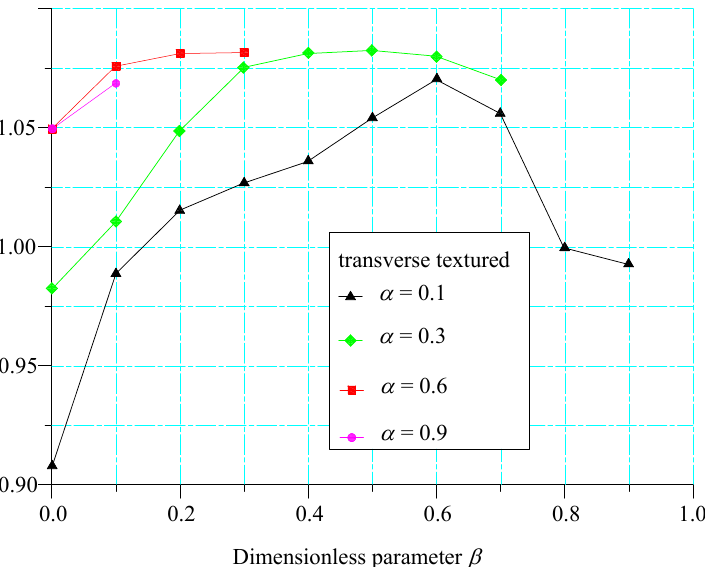
Figure 18. Influence of transverse texture position on dimensionless shear force on moving wall.